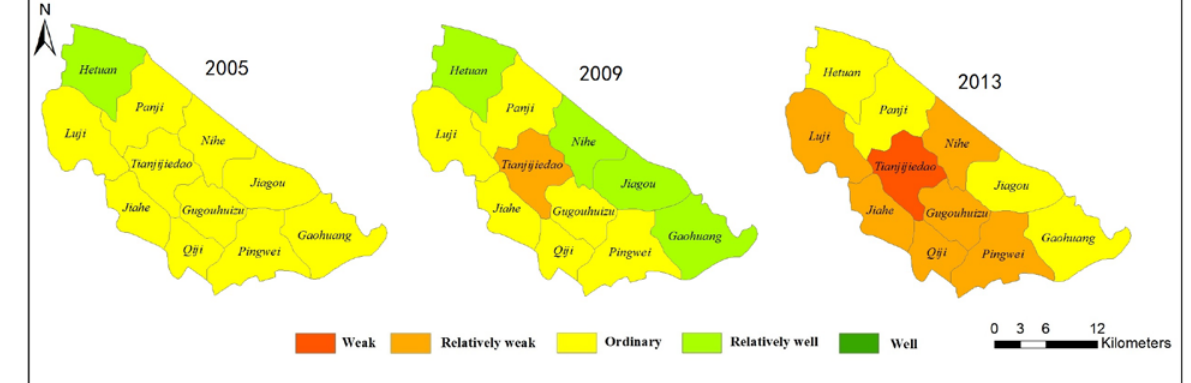
Figure 7. Change of ecosystem health for each town in Panji District from 2005 to